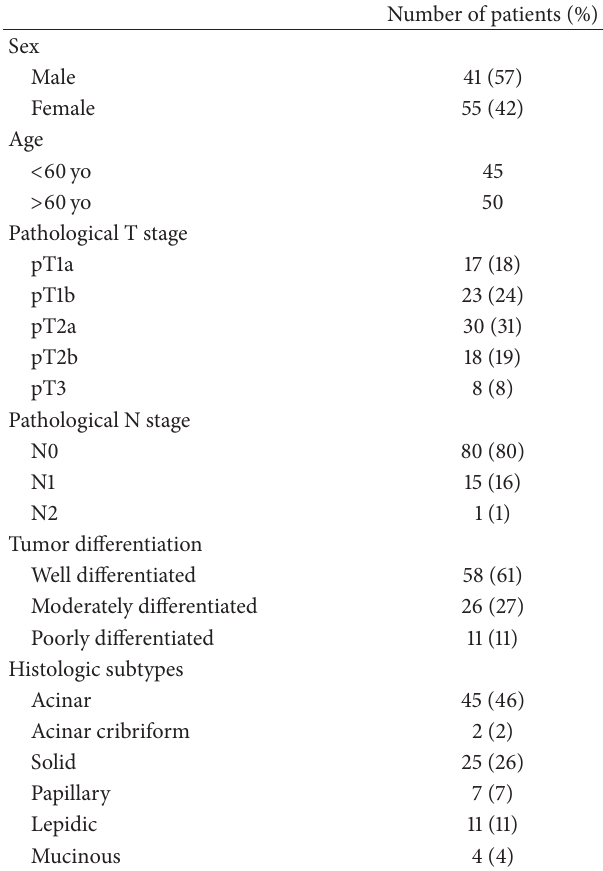
Table 1: Clinicopathological characteristics of